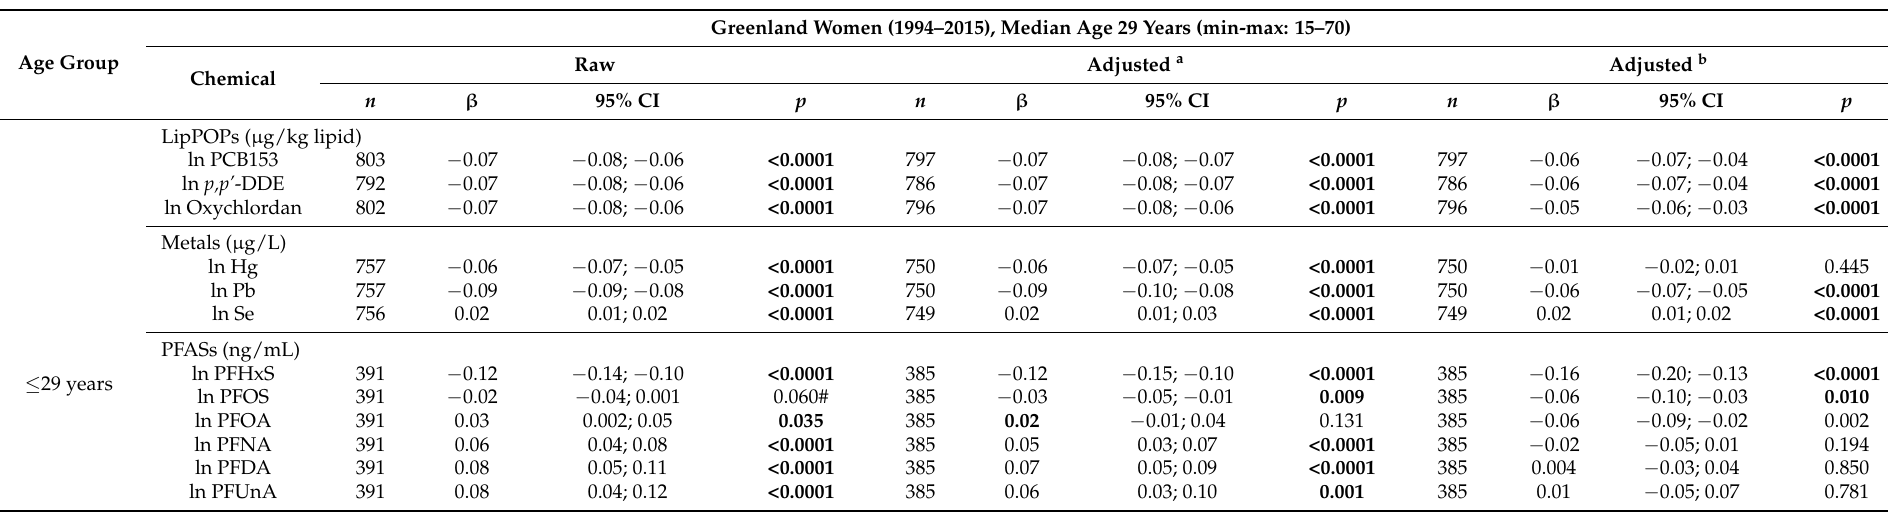
Table 6. Women across Greenland : age stratified time trend of lipPOPs, metals and PFASs